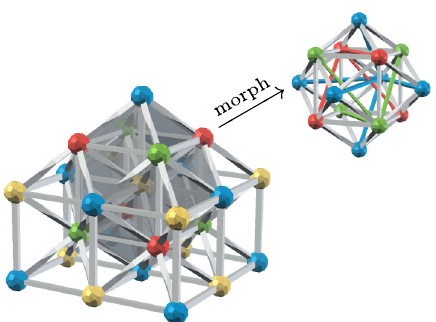
FIG. 5. Morphing a ball-like region of a 3D color code. Qubits are on tetrahedra; X and Z stabilizers are associated with ver- tices and edges, respectively. We shade a ball-like region (with an associated [[24,11,2]] ball code) and show its transformation under